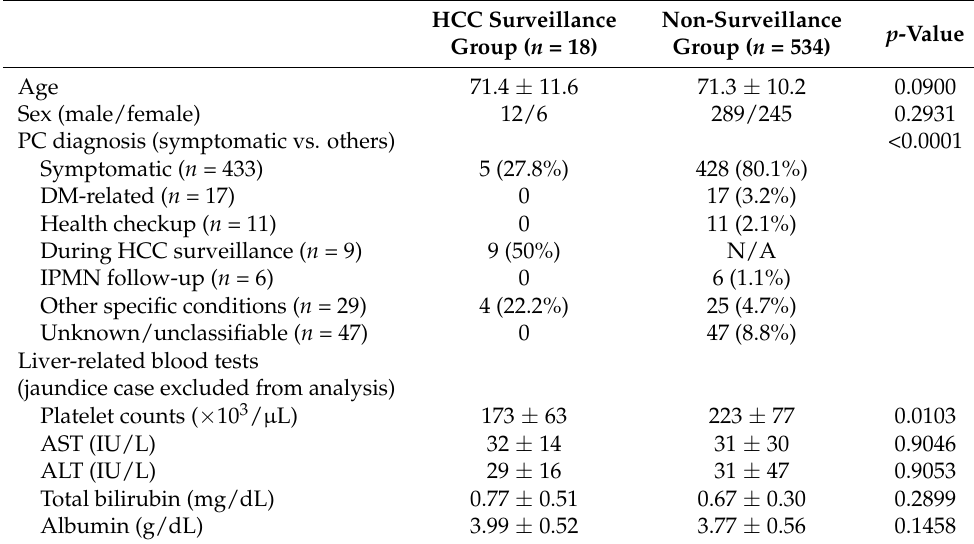
Table 1. Baseline demographics at PC